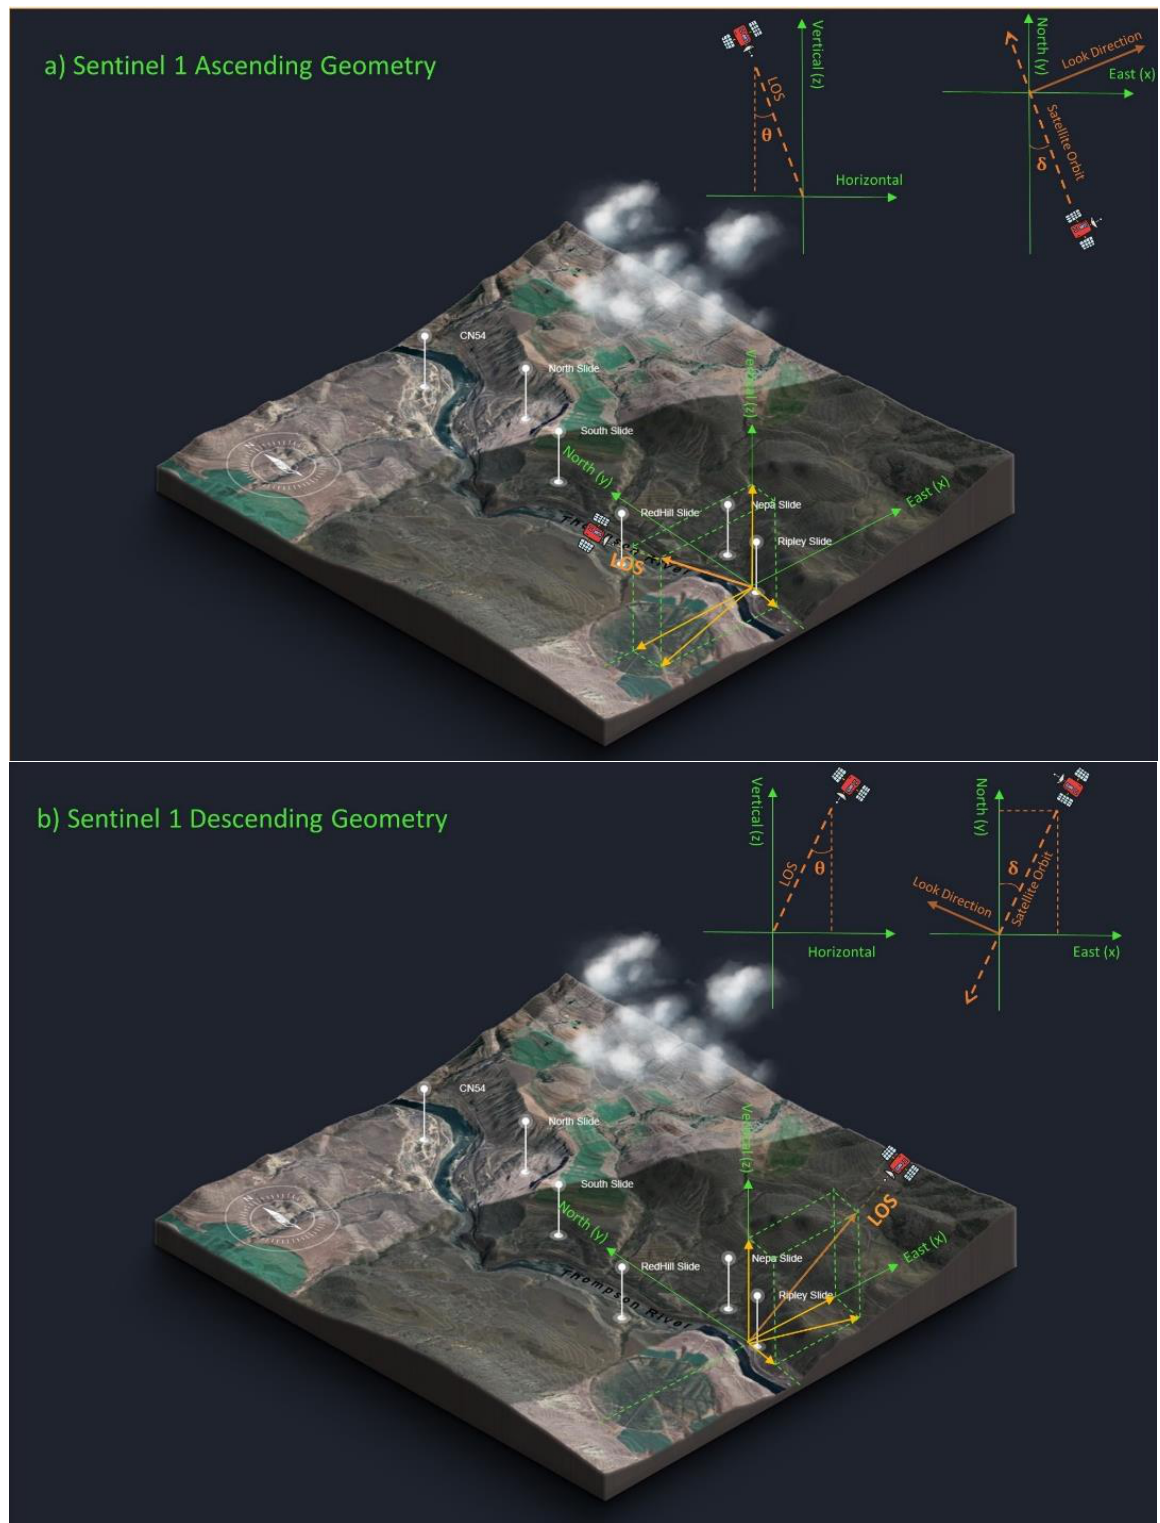
Figure 4. Geometry of the image acquisitions along the ascending ( a ) and descending ( b ) orbits (inspired by ground deformation InSAR analysis over the Thompson Canyon, British Columbia, Technical Details, August 2018, by TRE Group).